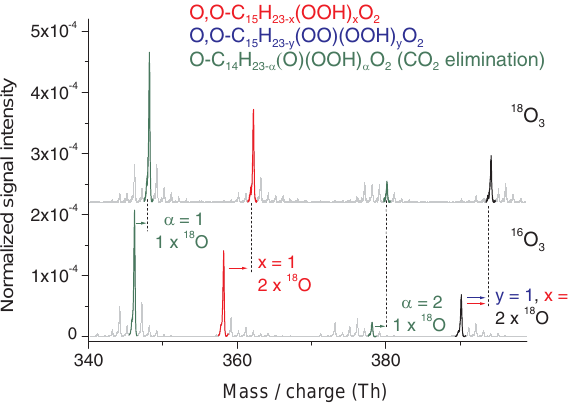
Figure 2. Ozonolysis of β -caryophyllene using 16 O 3 (lower part) and 18 O 3 (upper part) and applying acetate ionization in the analysis. Highly oxidized RO 2 radicals of the three product groups, simple AutOx., O,O–C 15 H 23 − x (OOH) x O 2 , with x = 1 and 2 (in red), ext. AutOx., O,O–C 15 H 23 − y (OO)(OOH) y O 2 with y = 1 (black signal with blue label) and ext. AutOx. -CO 2 , O– C 14 H 23 − α (O)(OOH) α O 2 with α = 1 and 2 (in green) were de- tected. The black-coloured signals at nominal 390Th ( 16 O 3 ) and nominal 394Th ( 18 O 3 ) stand for the sum of the signal from the sim- ple AutOx. RO 2 radical O,O–C 15 H 23 − x (OOH) x O 2 with x = 2 and from the ext. AutOx. RO 2 radical O,O–C 15 H 23 − y (OO)(OOH) y O 2 with y = 1. Only the arrows and inscriptions ( y = 1; x = 2) indi- cate the colours of the product groups. When exchanging 16 O 3 by 18 O 3 , the signals were shifted by two nominal mass units for each oxygen atom arising from the initial ozone attack. [ β - caryophyllene] = 8 . 6 × 10 10 , [O 3 ] = 8 . 8 × 10 11 moleculescm − 3 , re- action time is